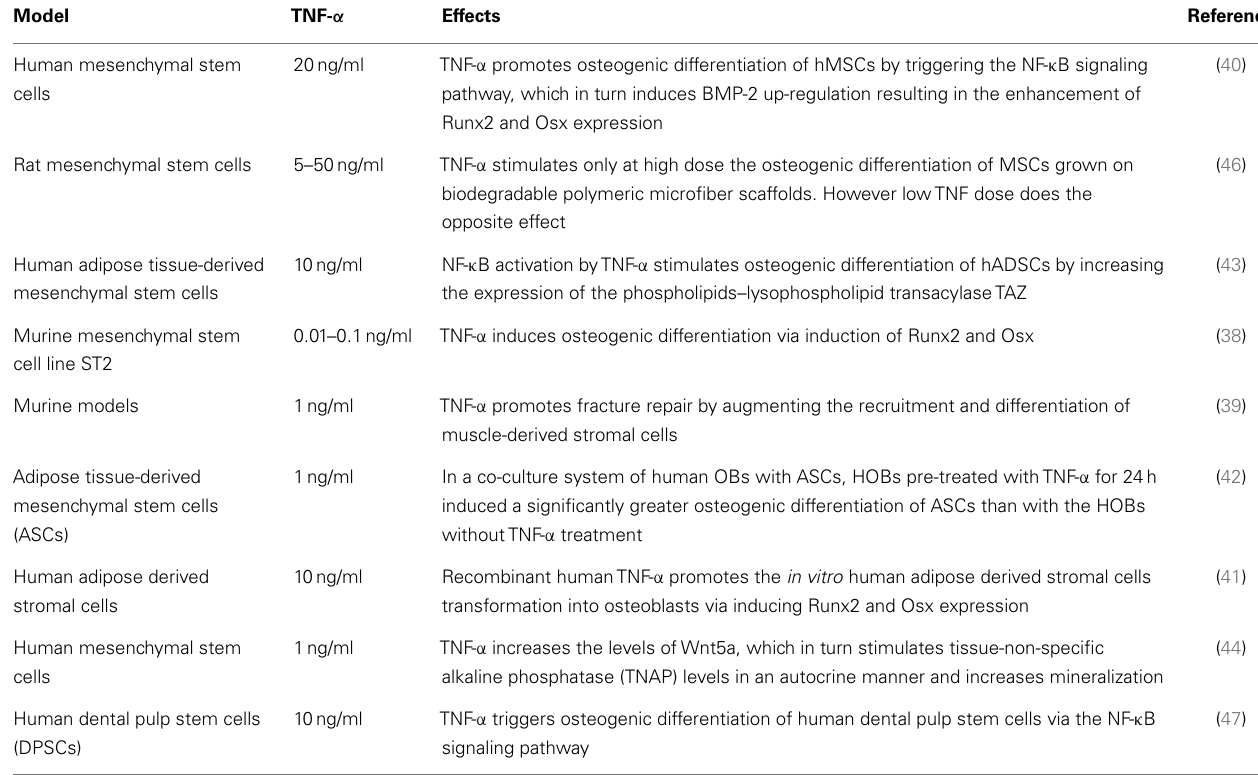
Table 2 | Overview of studies indicating aTNF-mediated activation of osteogenic differentiation